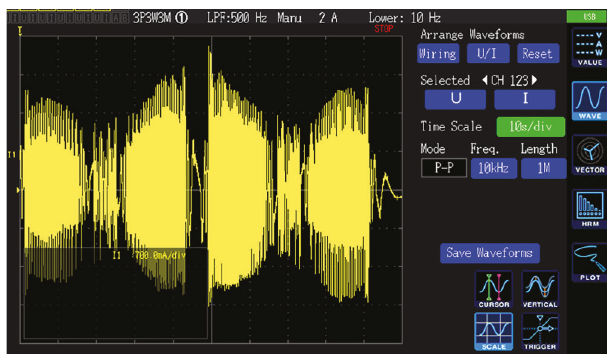
Figure 26: A working interface of the power